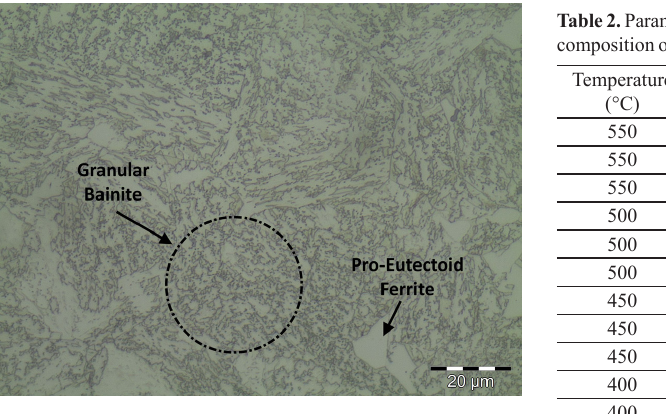
Table 2. Parameters used for plasma nitriding of samples using a gas composition of 76 vol.% nitrogen (N